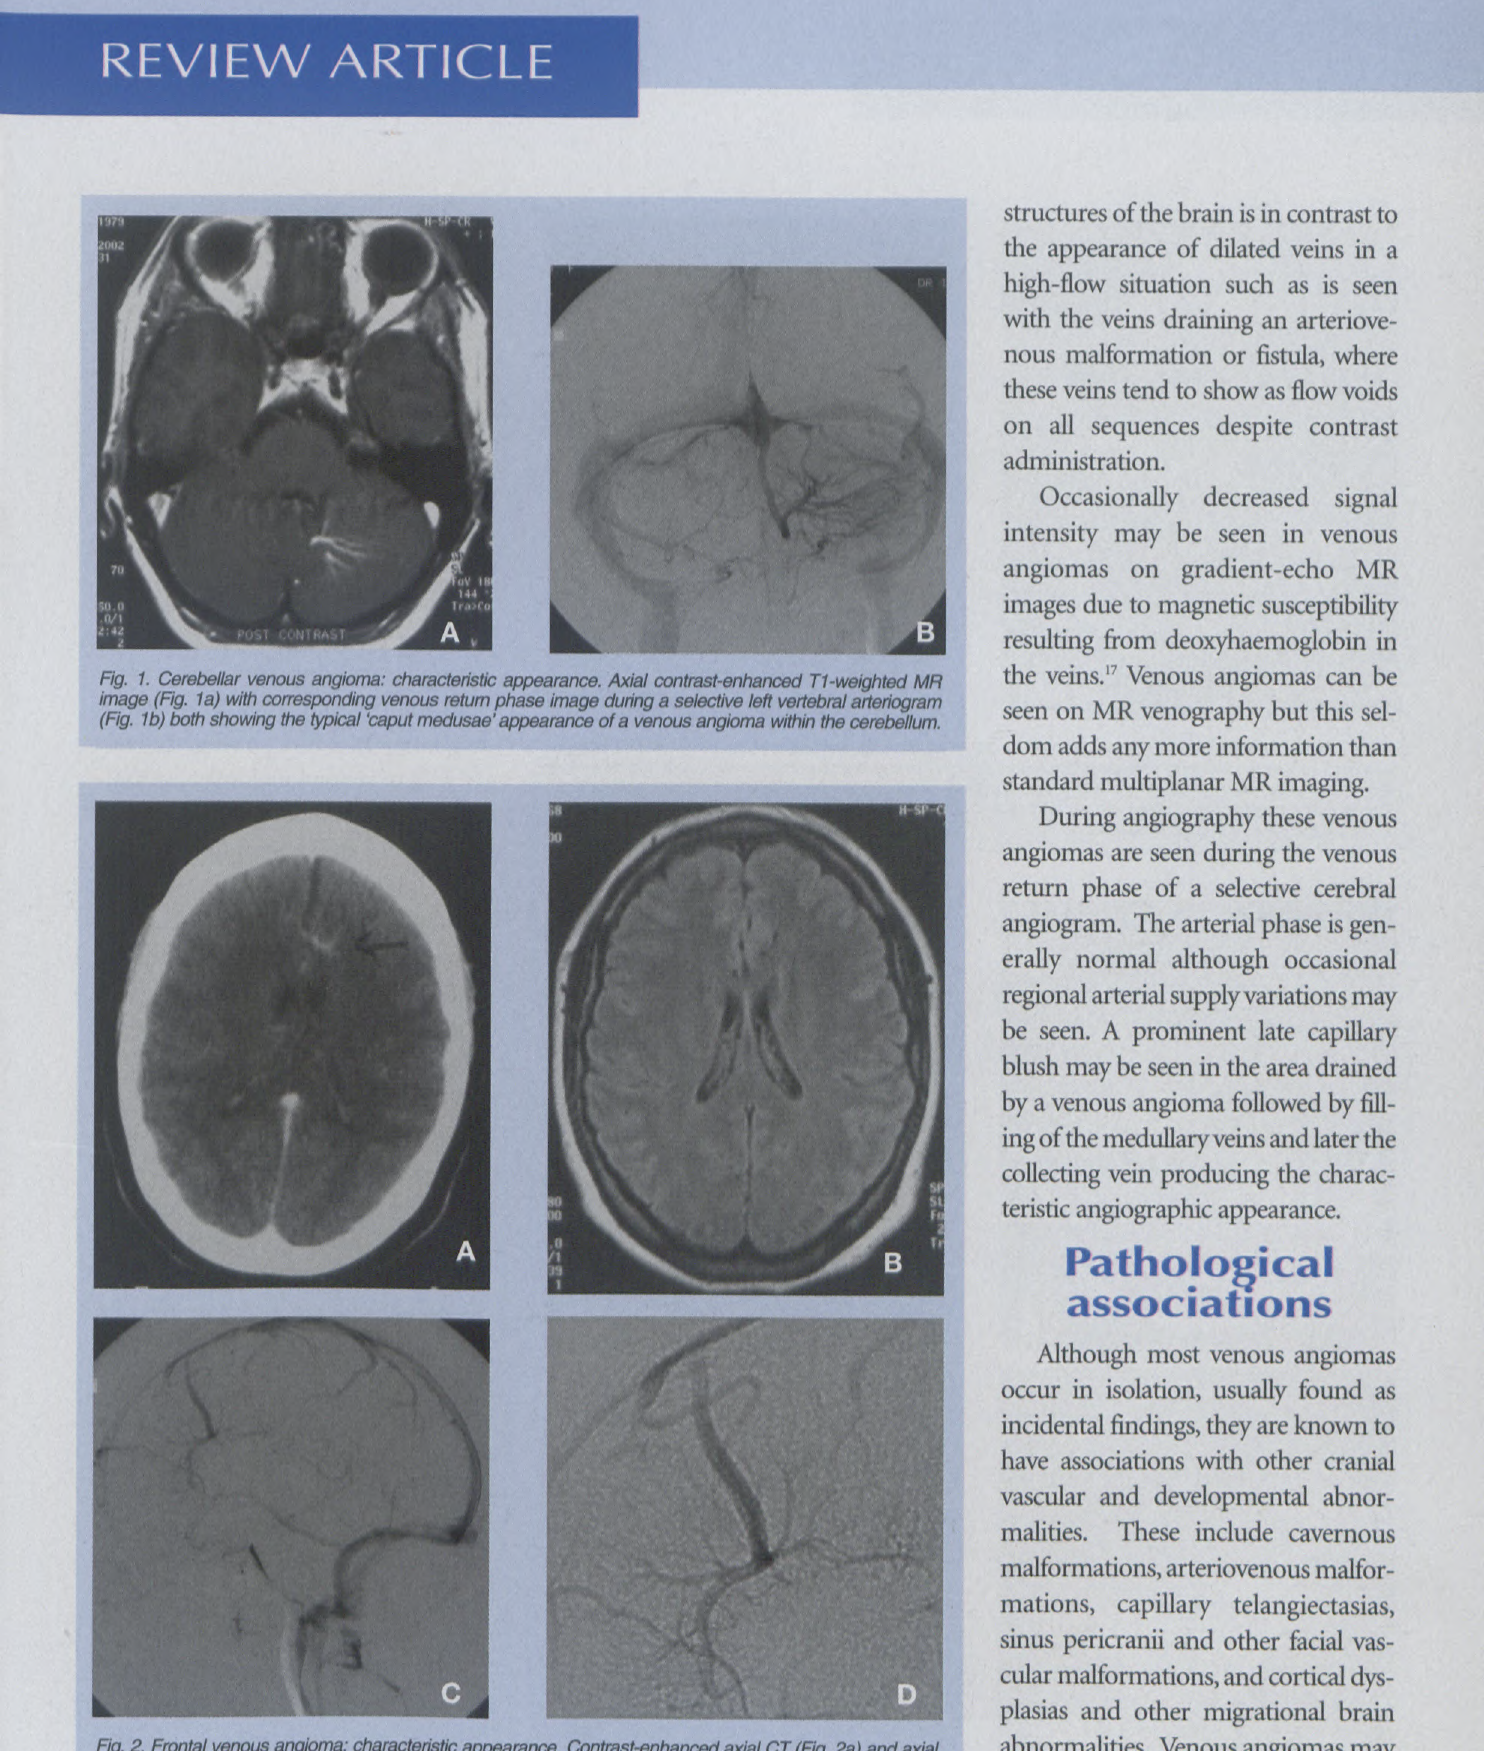
Fig. 2. Frontal venous angioma: characteristic appearance. Contrest-enhanced axial CT (Fig. 2a) and axial proton-density MR (Fig. 2b) images at the same level showing a venous angioma in the left frontal lobe. It shbws as an enhancing stll./Ctureon the tenner and as a How-voidon the latter. The venous retum phase images of a selective left intemal carotid arteriogram (Figs za. 2d) show the same deep venous angioma draining